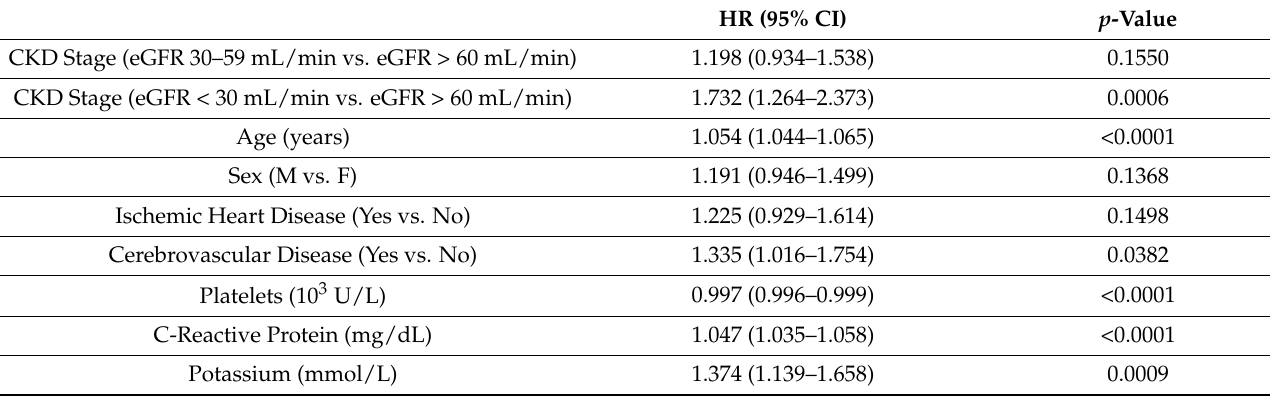
Table 2. Cox proportional hazards model on the effect of CKD on in-hospital mortality adjusted by age, sex, and selected clinical and laboratory variables. n = 2223, n of deaths = 371.